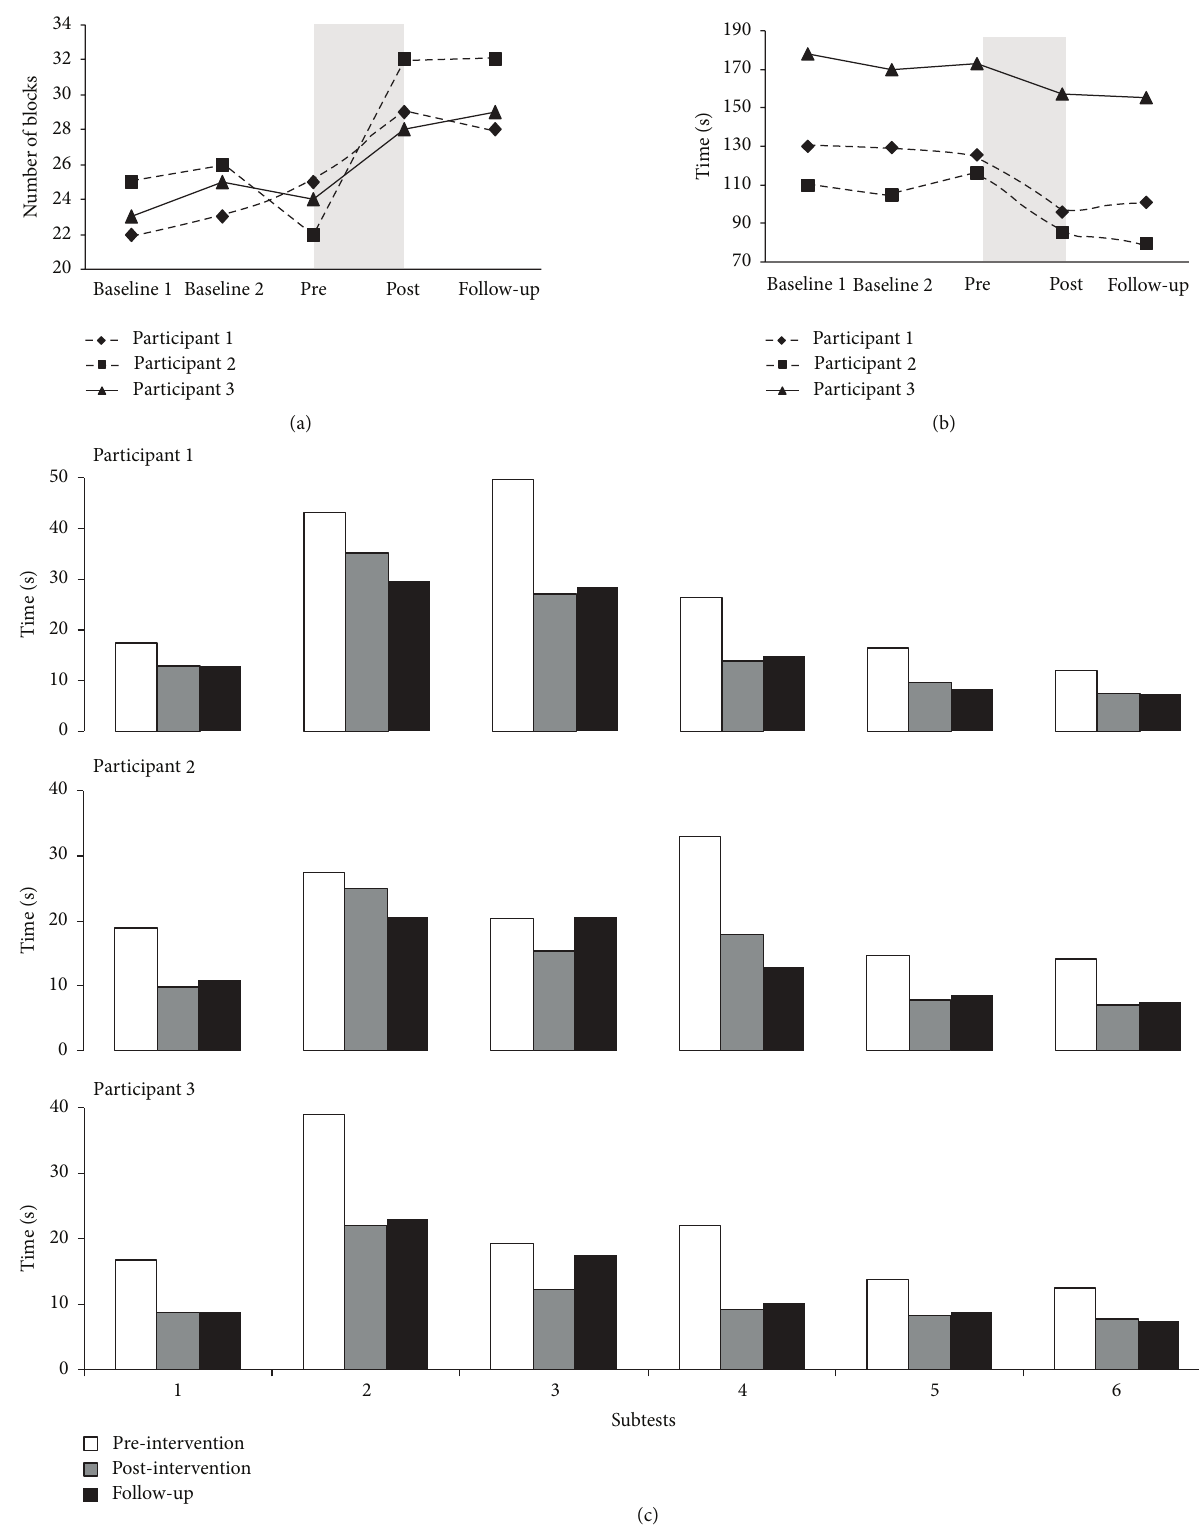
Figure 1: Scores of the three participants at different time points on the box and block test (a), nine hole peg test (b), and the Jebsen hand function test (c). For the box and block test, the scores represent the maximum number of blocks transported from one box to the other in 60 seconds. For the nine hole peg test, the time required to place and remove nine dowels into a nine holes is represented. For the Jebsen hand function test, the time required to complete the following subtests is shown: (1) simulating page turning; (2) lifting small common objects; (3) simulated feeding; (4) stacking checkers; (5) lifting large, light objects; (6) lifting large, heavy